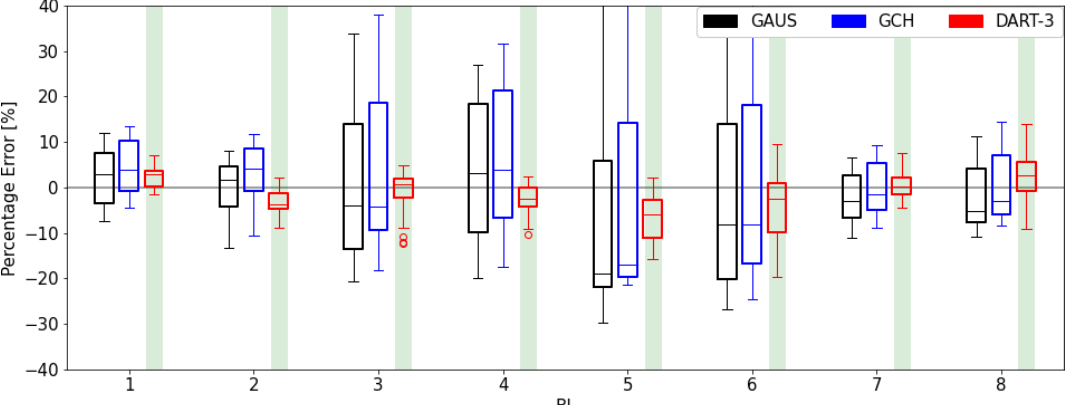
Figure 9. Same as Fig. 8, but only for cases with β = 0 ◦ , i.e., without derating the turbine.